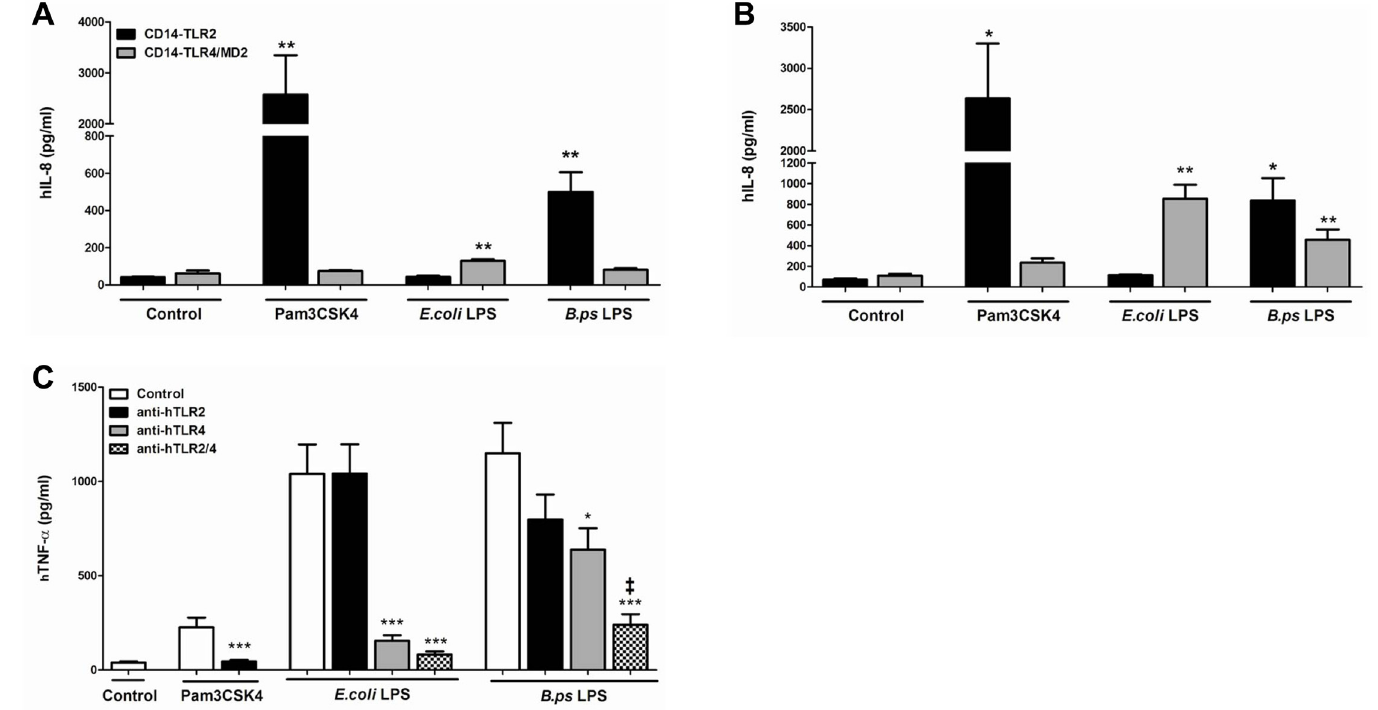
Fig 2. LPS of B . pseudomallei signals via both TLR2 and TLR4 in in vitro human models. Human Embryonic Kidney (HEK)-293 cells, stably transfected with either CD14-TLR2 or CD14-TLR4/MD2 were stimulated with purified LPS of B . pseudomallei 1026b (100 ng/ml), LPS of E . coli 0111:B4 (100 ng/ml), PAM3CSK4 (100 ng/ml) or DMEM+ 10% FCS for 6h (A) or 24h (B) before measurement of interleukin (IL)-8 in the supernatant (n = 3). Human whole blood was pre-treated for 30 minutes with respectively RPMI 1640 medium, anti-TLR2 antibody (2500 ng/ml), anti-TLR4 antibody (1000 ng/ml) or both antibodies and hereafter stimulated with purified LPS of B . pseudomallei 1026b (100 ng/ml), LPS of E . coli 0111:B4 (100 ng/ml), PAM3CSK4 (100 ng/ml) or RPMI 1640 for 6h after which TNF was measured (C) (n = 3). An additive effect of TLR2 on TLR4 mediated signalling induced by B . pseudomallei -LPS was observed. Data are presented as means ± SEM. Results of two or three independent experiments were pooled. Mann-Whitney- U tests were performed. * P < 0.05; ** P < 0.01, *** P < 0.001 vs. control (or no antibodies). ‡ P < 0.05 anti-TLR2 and 4 vs. anti-TLR4 alone.